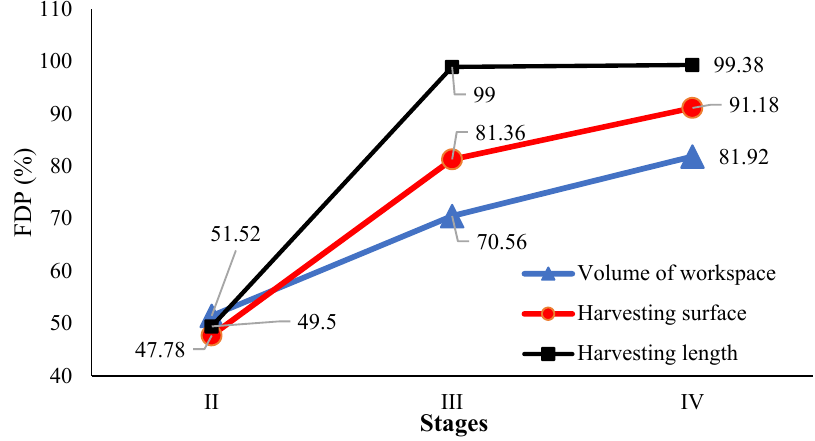
Figure 7. FDP of development stages.